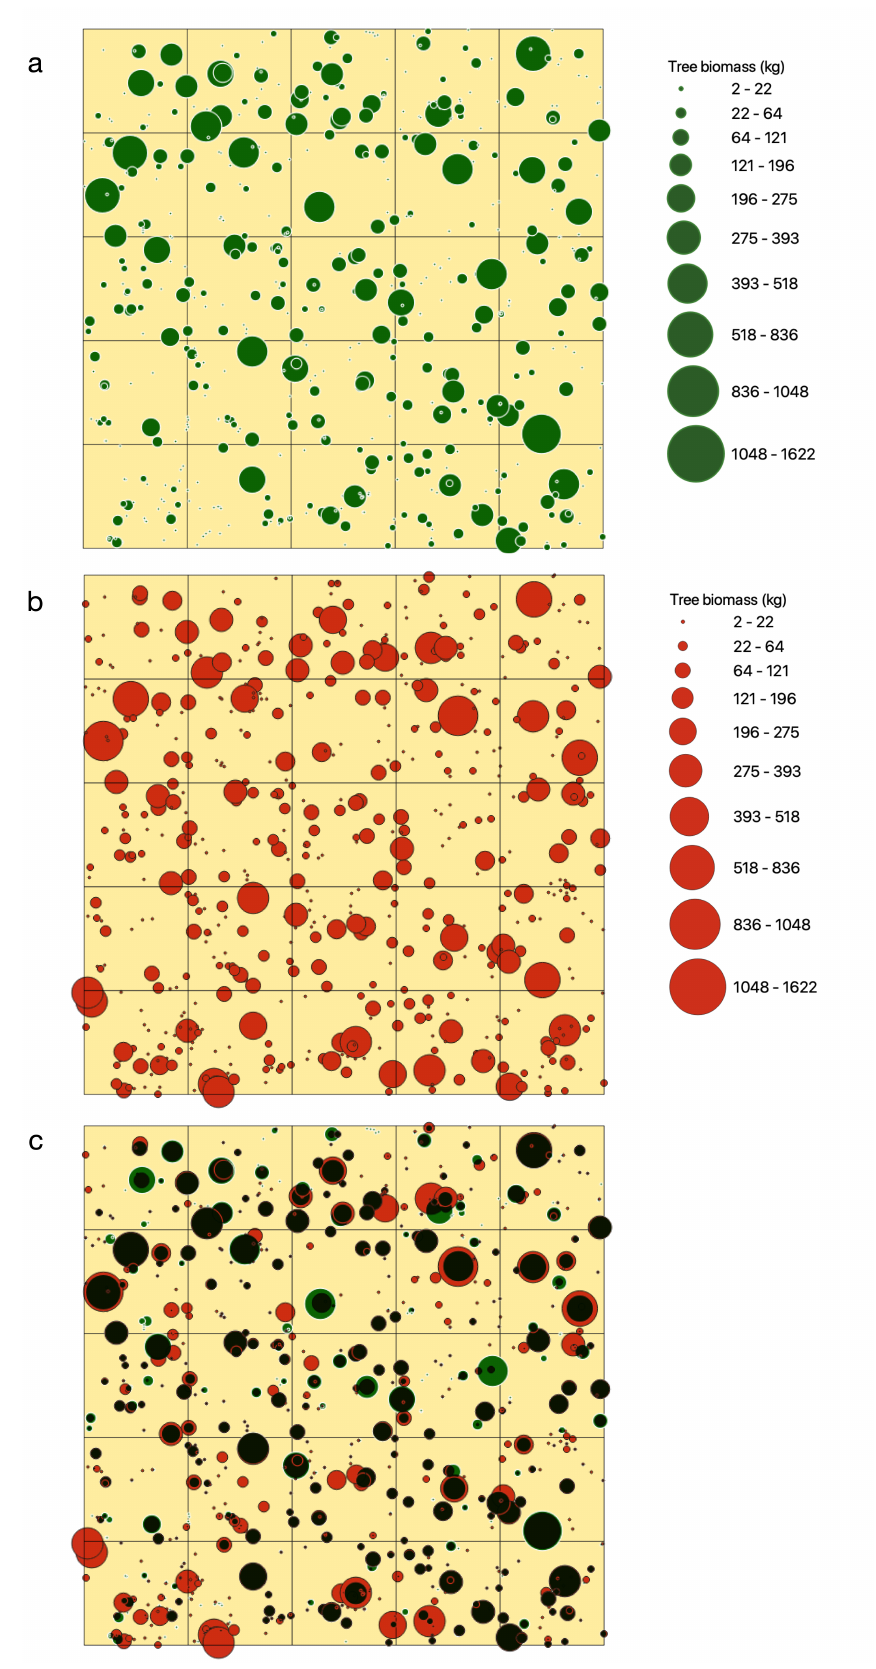
Figure 11. Spatial distribution of tree biomass as mapped through field inventory ( a , n = 572) and from TLS ( b , n = 669) using DBH-based allometric equations. Agreement, omissions, and commissions between field and TLS mapping are shown in ( c ) with overlay